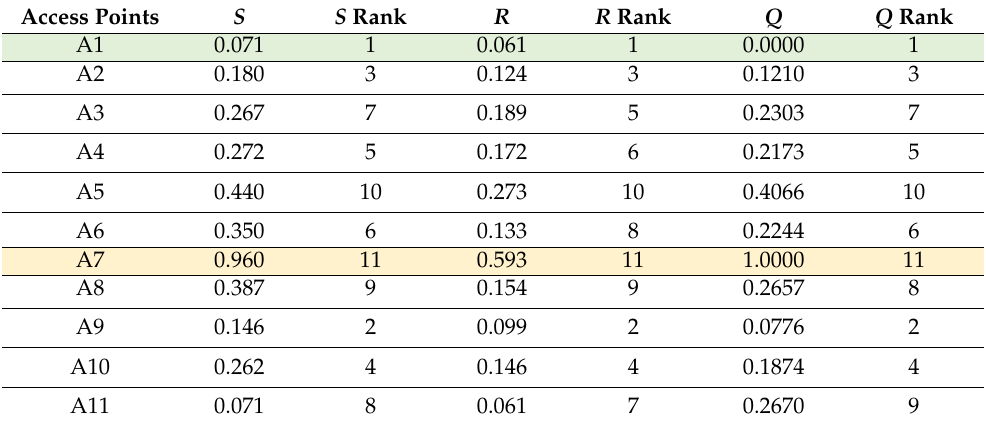
Table 22. Final VIKOR prioritization